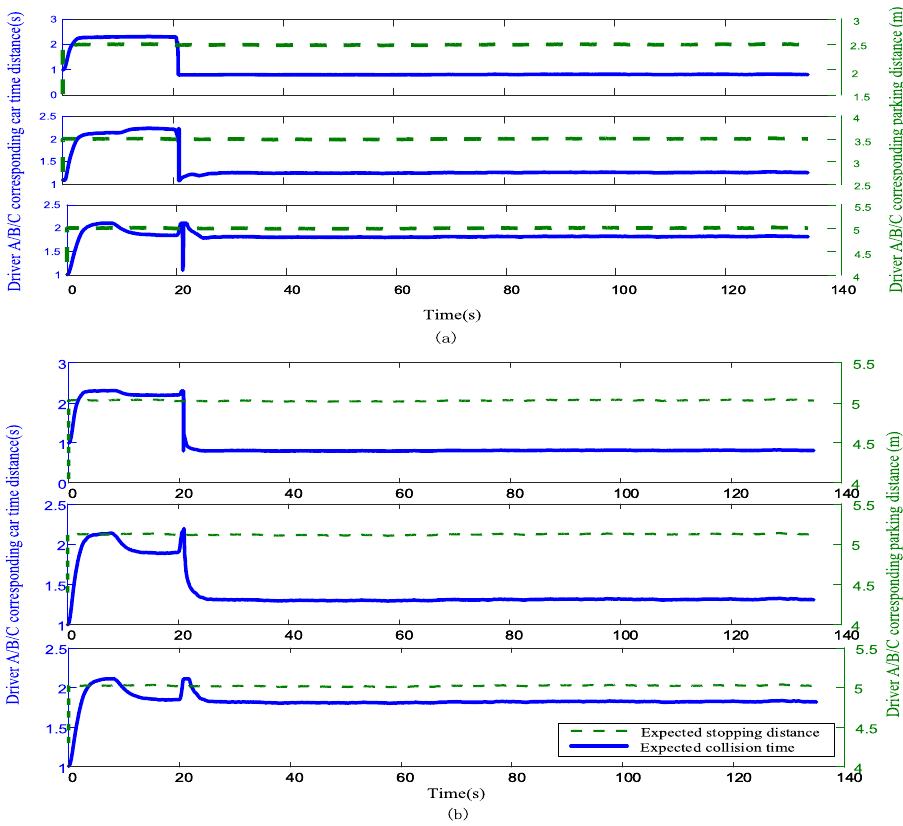
Figure 9. ( a ) Identification curves of three types of driver characteristics based on this model ( b ) Identification curves of three types of driver characteristics based on the control group